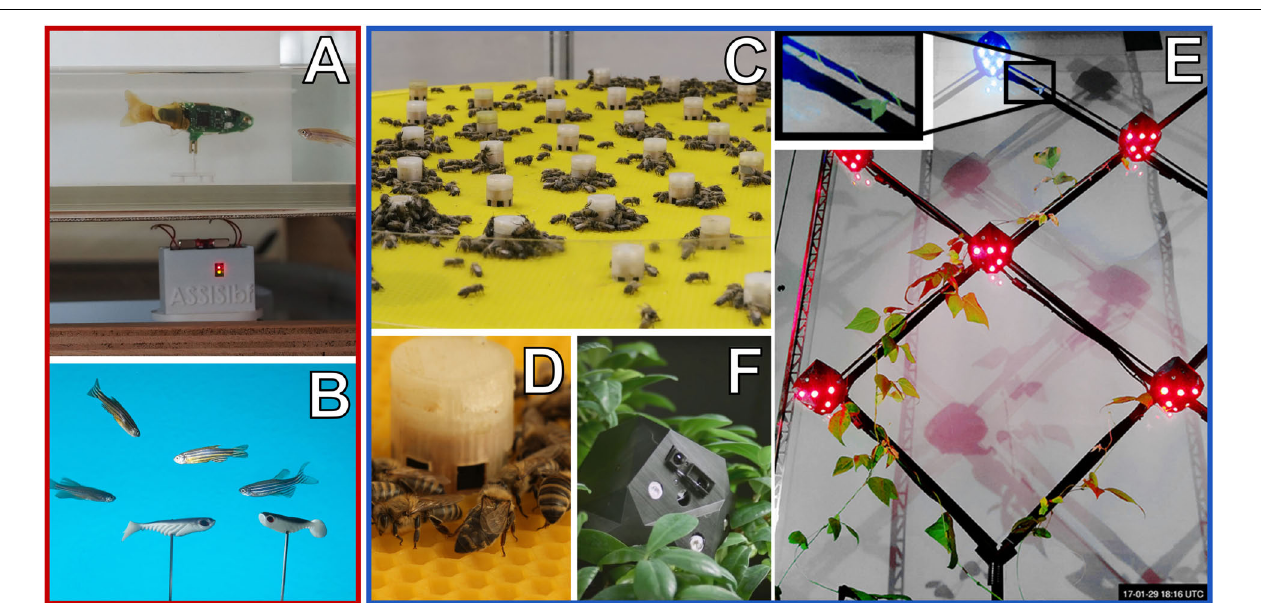
FIGURE 5 | Examples of mobile robots (red frame) and immobile artefacts (blue frame) that can interact with animals or plants by emitting various stimuli. (A) Free-moving fish robot with an active (tail-beating) lure that was developed in the project ASSISI_bf for interacting with zebrafish. (B) Close-up of a mixed swarm of fish robots (only coupled lures visible) and zebrafish. (C) Horizontal array of combined actuator sensor units (CASUs) that was developed in the project ASSISI_bf for interacting with honeybees. (D) Close-up of one CASU surrounded by honeybees. (E) Vertical array of CASUs, developed in the project flora robotica to guide plant growth; inset frame shows a plant tip approaching the top-most robot (Figure “ Main result; predefined-pattern experiment ”: from Wahby et al., 2018, licenced under CC BY 4.0; colours modified). (F) Close-up of a CASU to guide plant growth, surrounded by